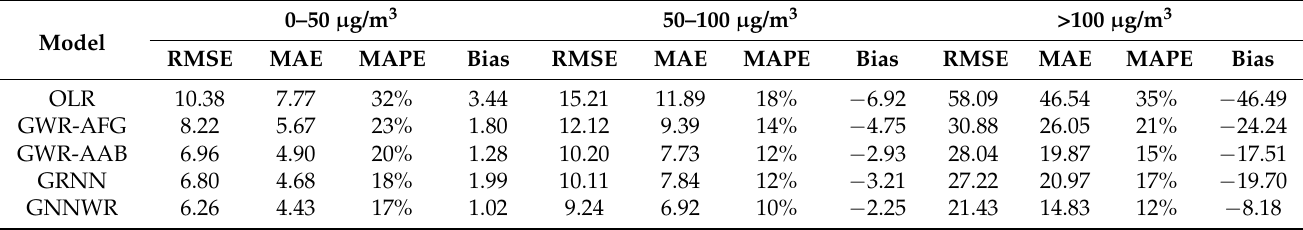
Table 2. Model performance with PM 2.5 concentrations in certain